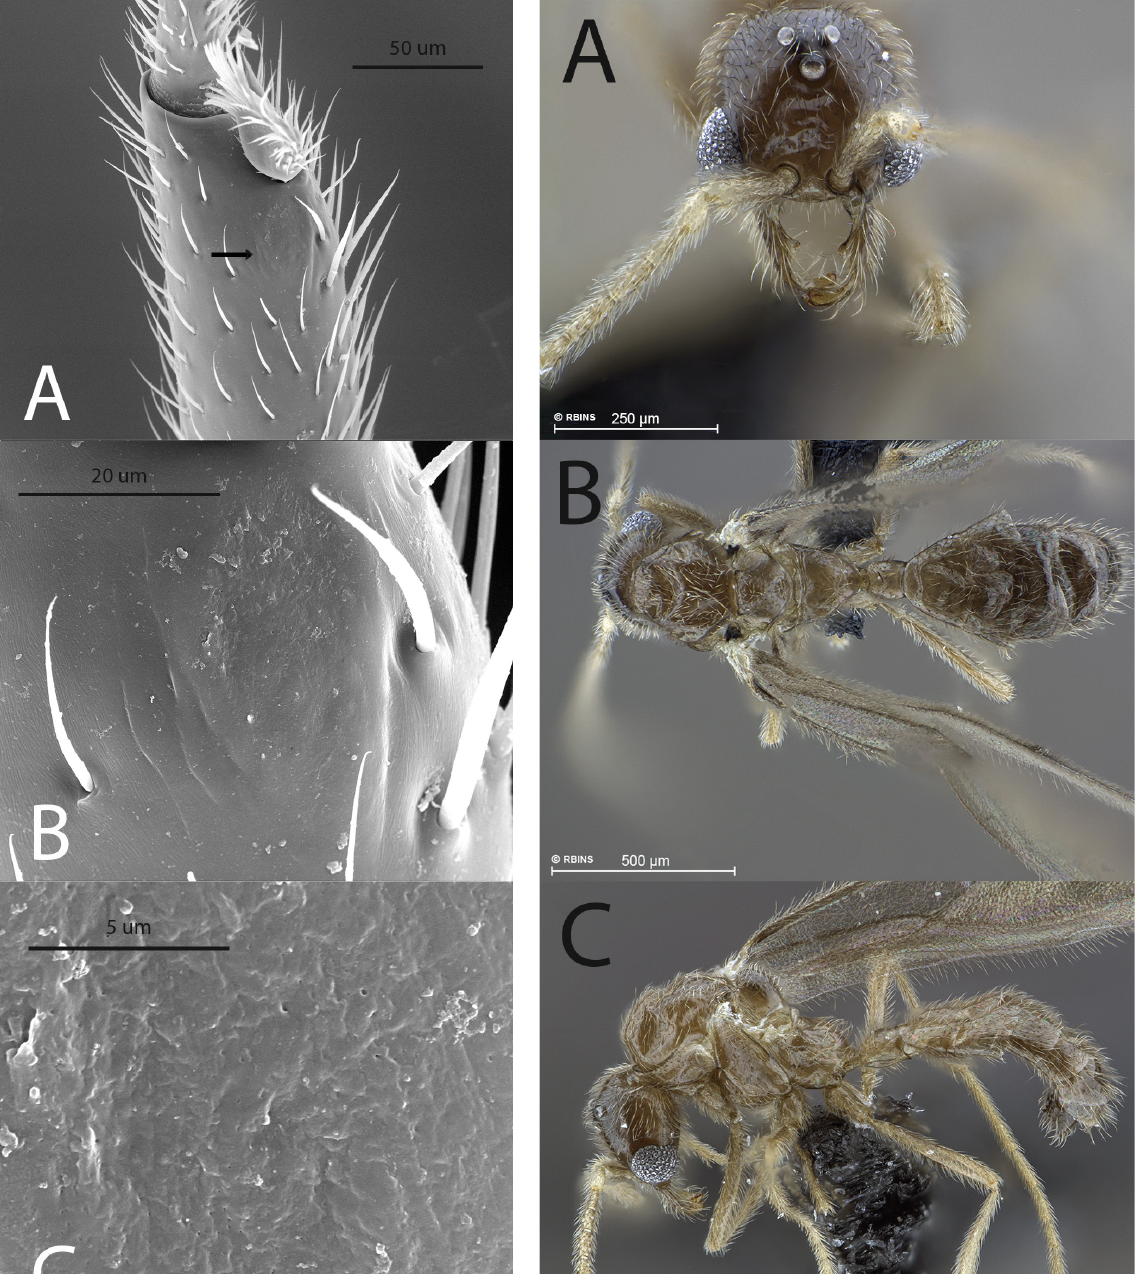
Fig. 7. Leptanilloides prometea Delsinne & Denoso sp. nov. Scanning electron micrographs of the metatibial apex of paratype worker (specimen code 4052301), showing the meta- tibial gland pore plate (arrow) at different magnifications.